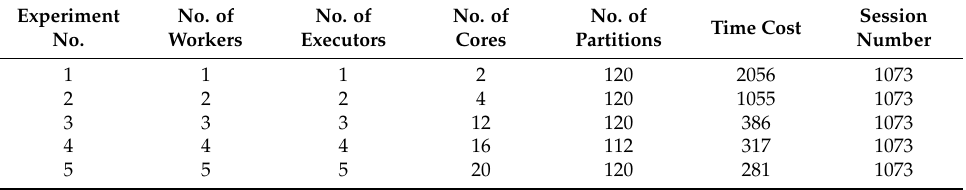
Table 2. The processing time of the February 2014 monthly log on different clusters.